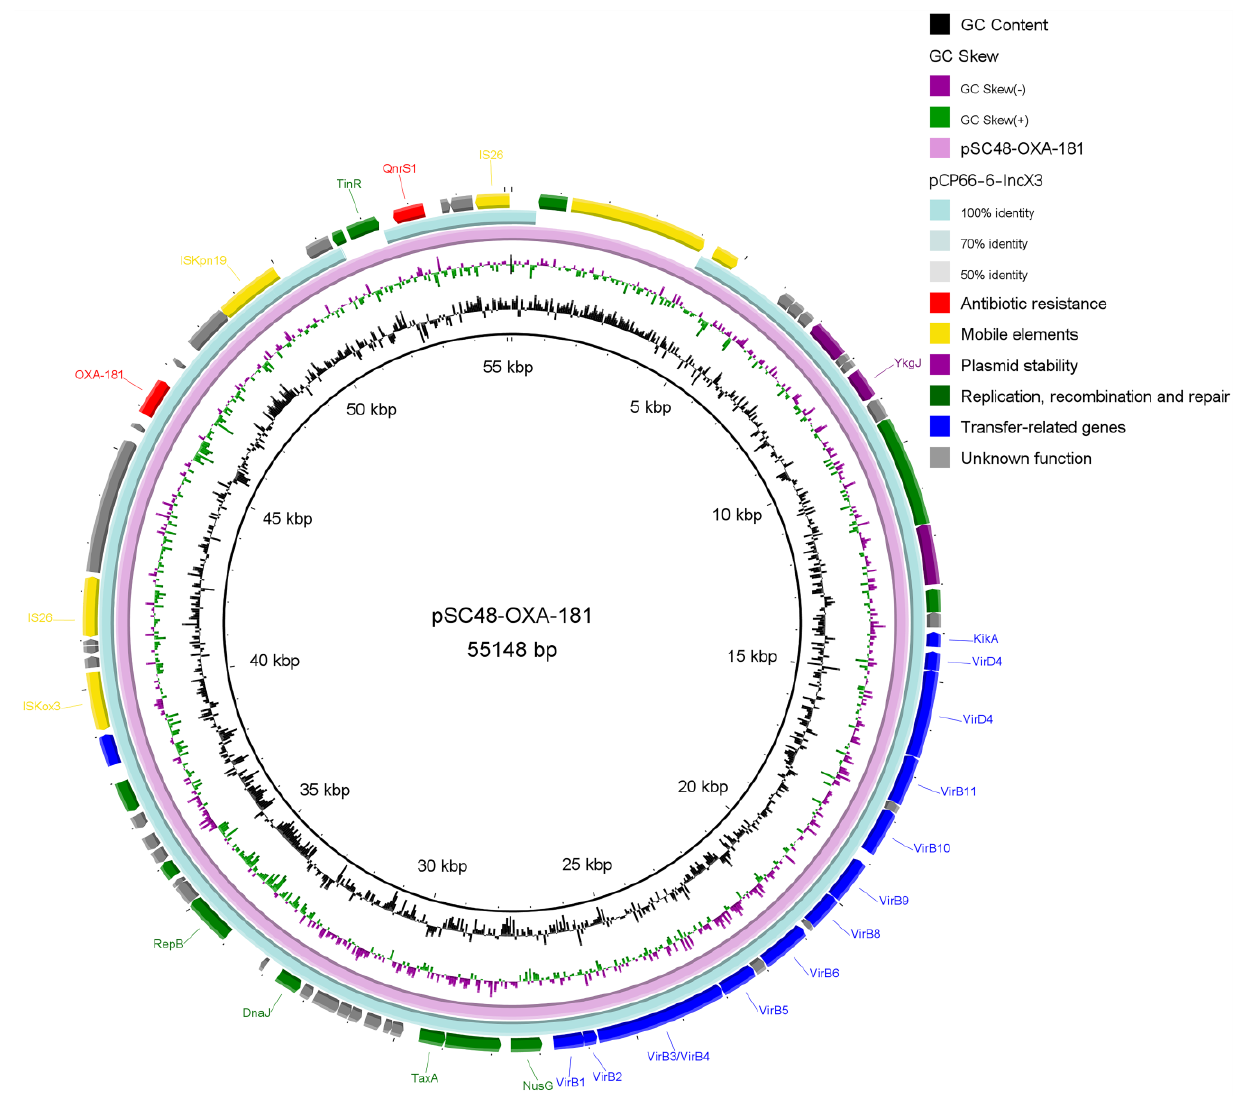
Figure 3. Ring diagram representation of plasmid pSC48-OXA-181. * From the inside to the outside: circle 1, scale; circle 2, GC content; circle 3, GC skew; circle 4, ring diagram of pSC48-OXA-181; circle 5, ring diagram of comparative plasmid pCP66-6-IncX3; circle 6, functional classified genes.